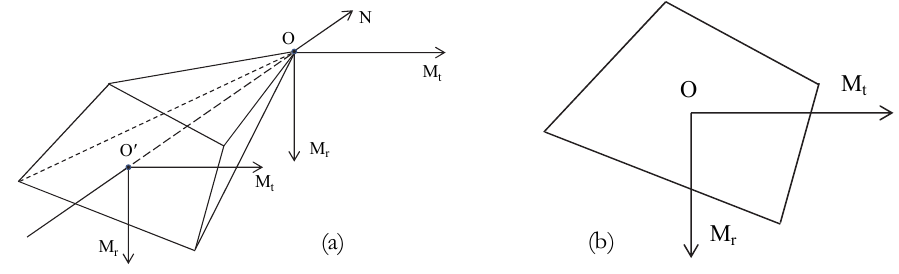
Figure 8: Yield domain. (a) The four planes through the origin O; (b) Cross